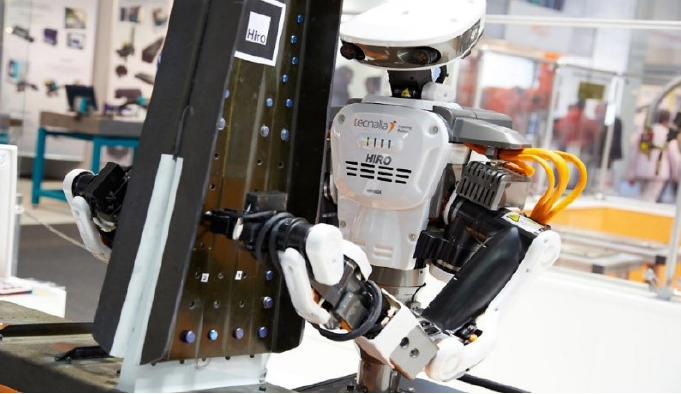
Figure 2. Robot Kawada Nextage Open of Tecnalia [13] .